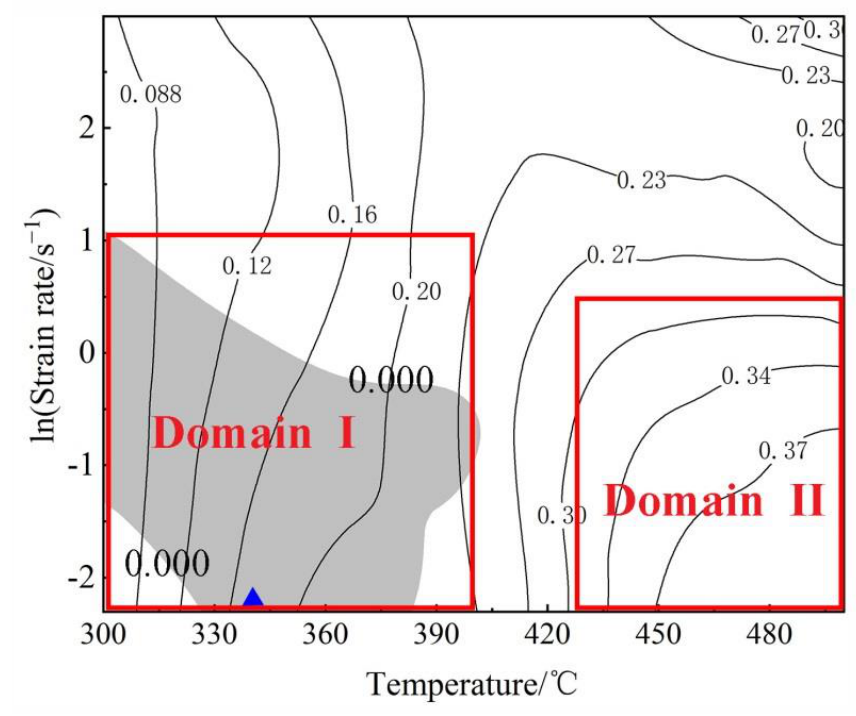
Figure 8. Processing map of Al-Zn-Mg-Cu alloy under strain 1.1.